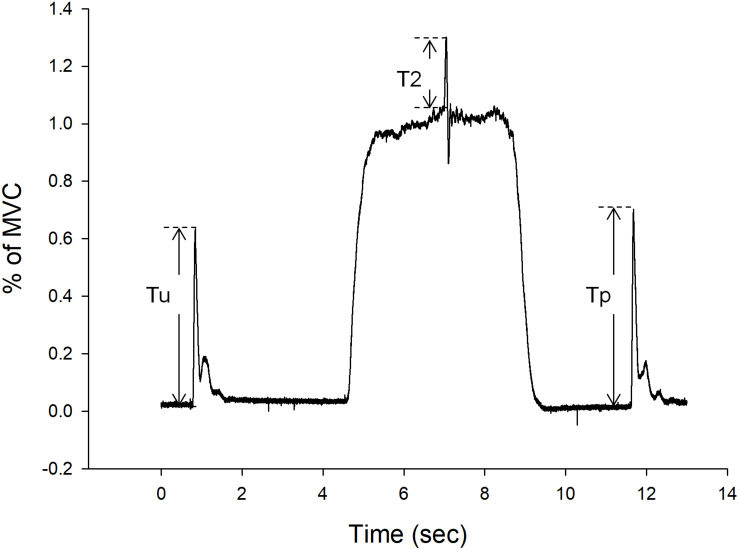
Representative force-time curves of voluntary activation (VA), and twitch force. During VA test, the Tu is the unpotentiated twitch and Tp is the potentiated twitch. Resting twitch force is the average of Tu and Tp. T2 is the interpolated twitch force.